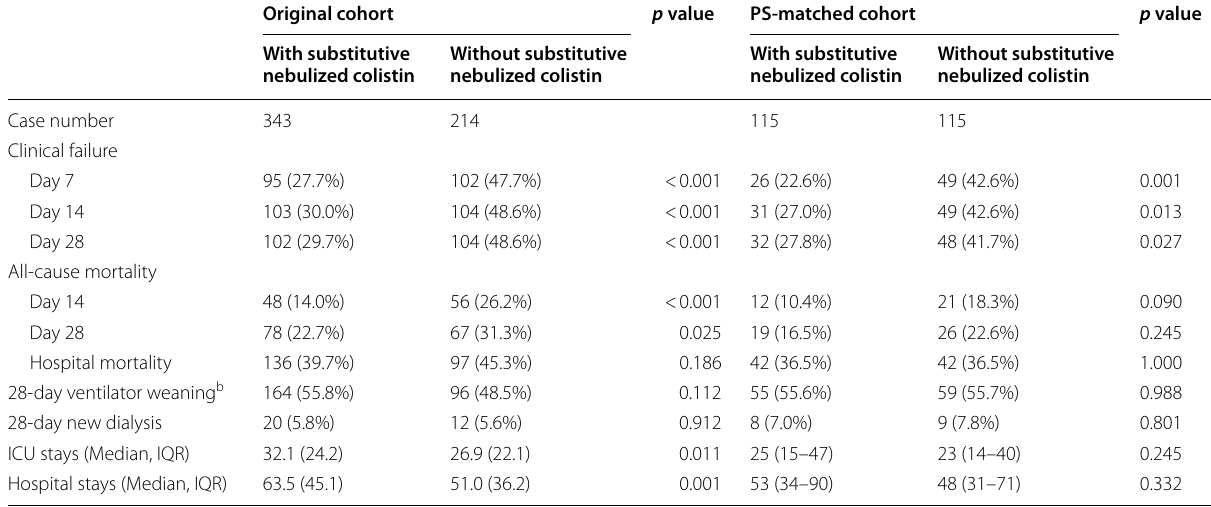
Table 3 Treatment outcomes of ICU patients with nosocomial pneumonia treated with and without nebulized colistin in substitutive strategy a